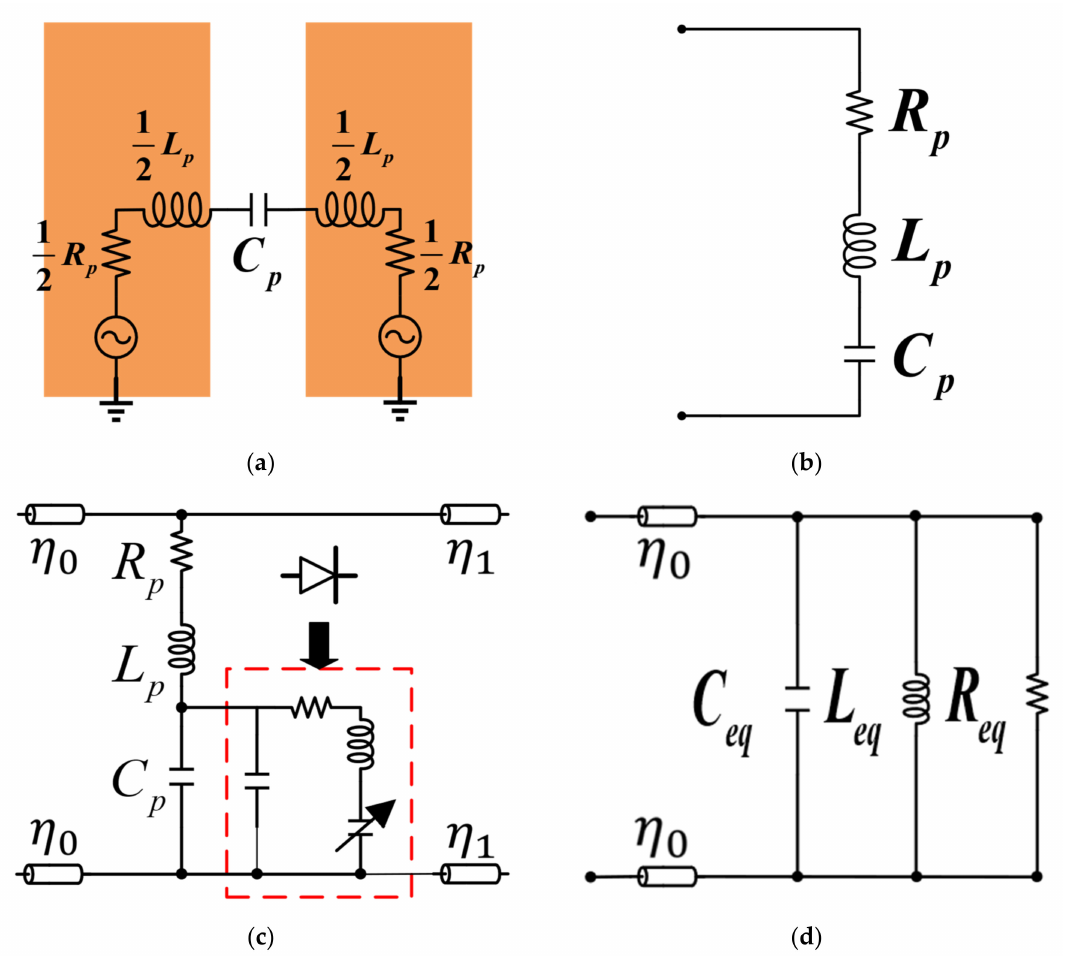
Figure 2. Equivalent circuit model of the MSRRA unit cell. ( a ) Metal patch and the equivalent lumped elements. ( b ) EC model of the metal patch. ( c ) EC model of the metal patch with a varactor diode; the varactor diode EC mode is in the red dash square. ( d ) Equivalent circuit model of the MSRRA unit